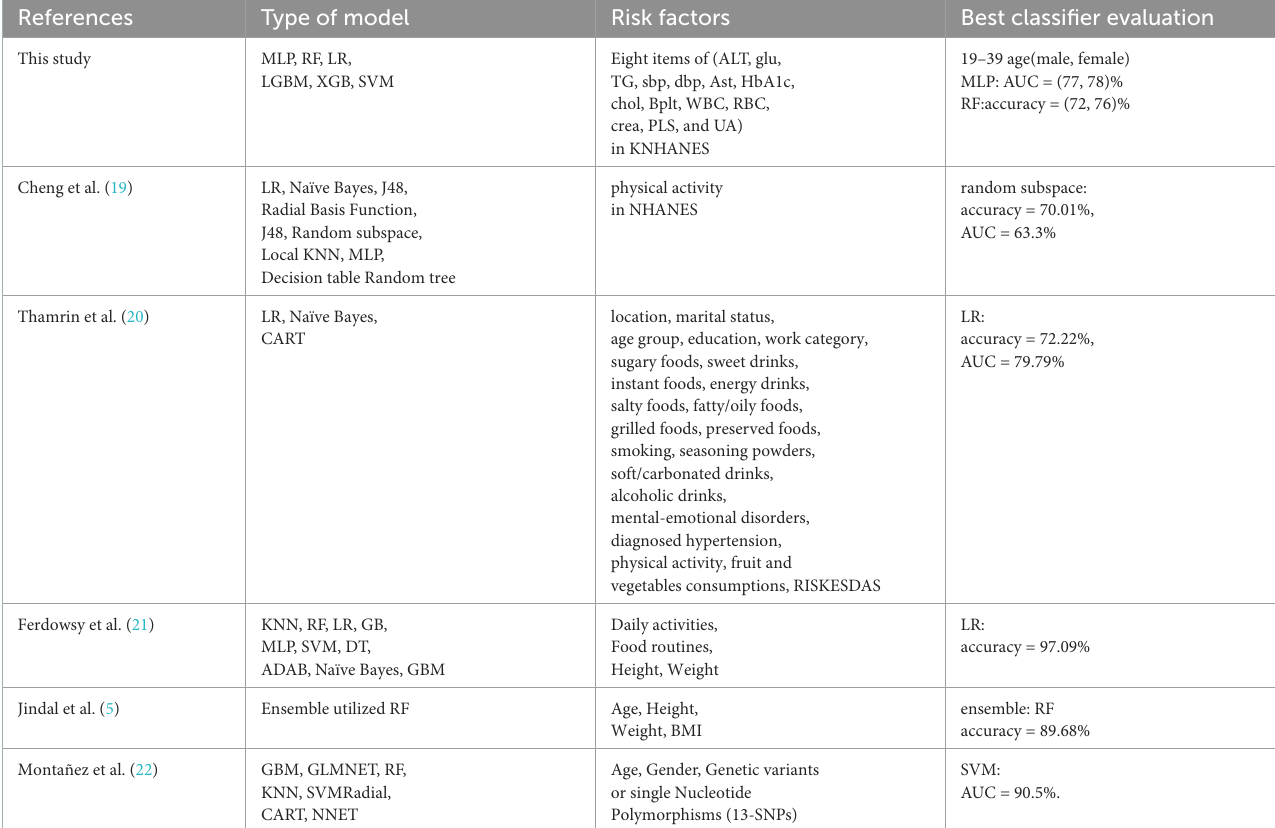
TABLE 1 Machine learning models and the risk factors related to adult